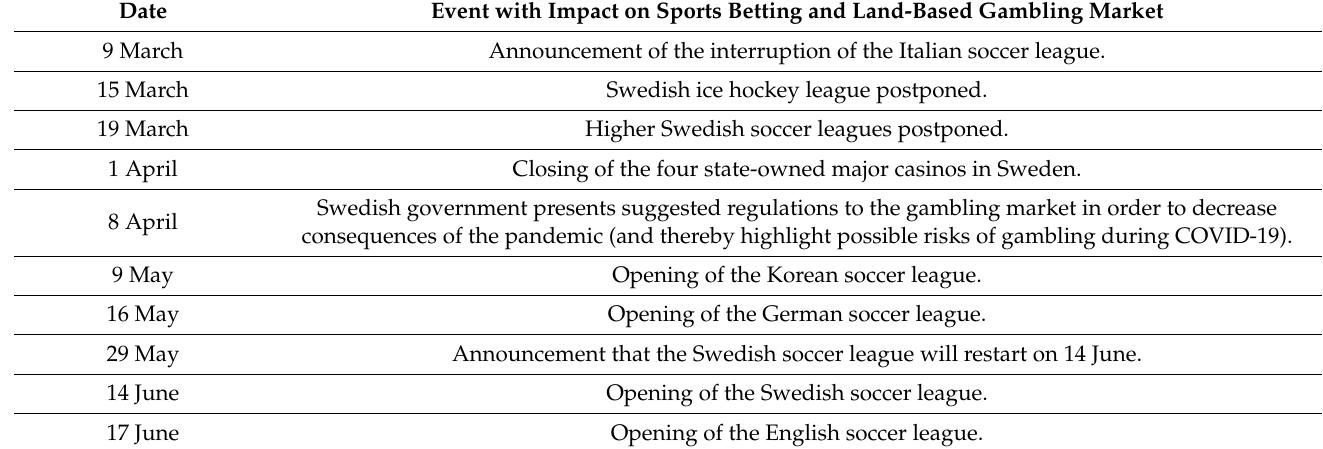
Table 1. Major events representing the impact of COVID-19 on sports betting and land-based casino gambling in Sweden during early phases of the pandemic in